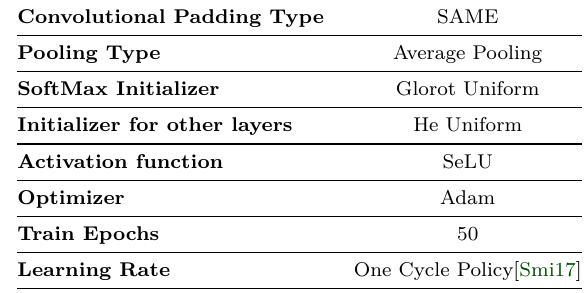
Table 9: Common hyperparameters for all the reported best architectures.